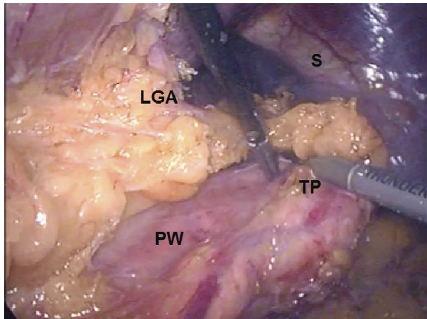
Figure 2: Intraoperative picture. S: spleen; TP: tail of the pancreas; LGA: left gastroepiploic artery; PW: the anterior surface of the pancreas which is also the posterior wall of the lesser